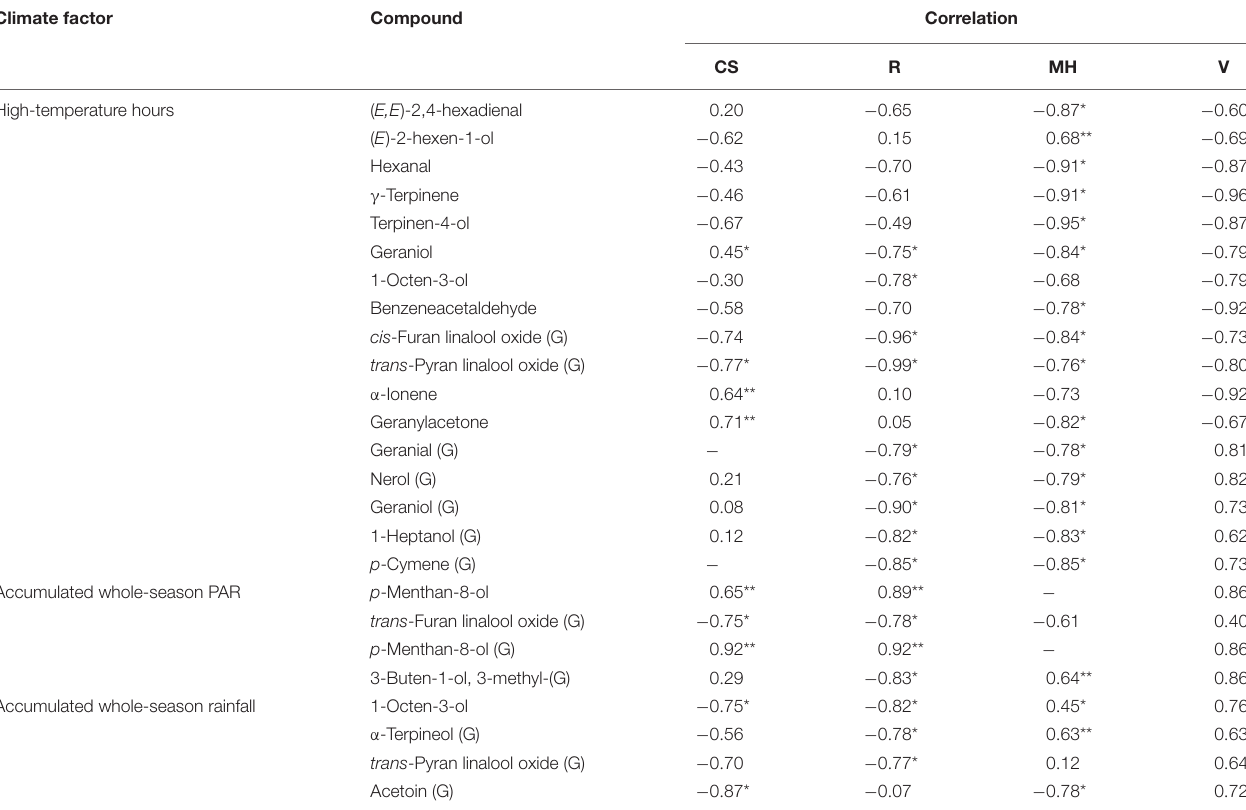
TABLE 3 | The Pearson correlation analysis between grape volatile compounds and climate factors. Climate